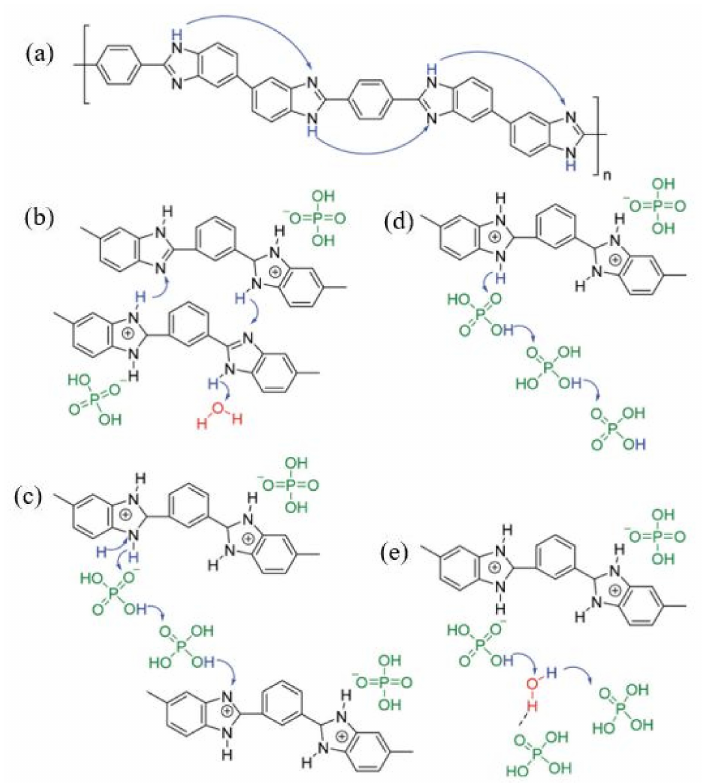
Figure 5. Mechanism of proton transfer in the phosphoric acid-doped PBI membrane. ( a ) Chemical